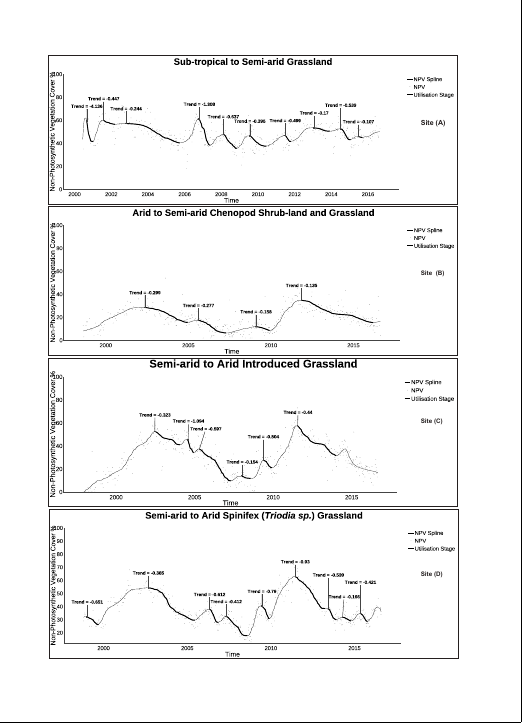
Figure 15. Example field site plots illustrating each sites growth cycle utilisation stage. Measures of utilisation are further illustrated as both the area under the curve and the slope of each stages decline.